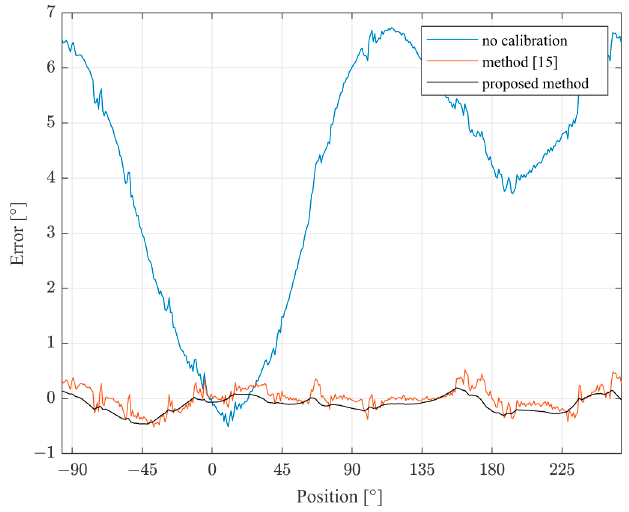
Figure 9. The deviation of the angle from the reference before and after the correction, with the inclined sensor.